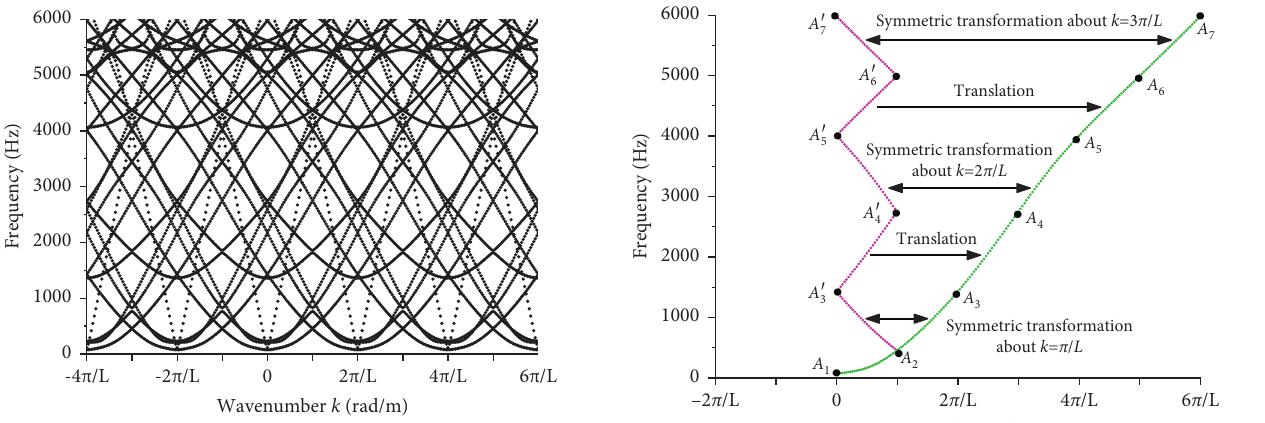
Figure 2: The original results of dispersion